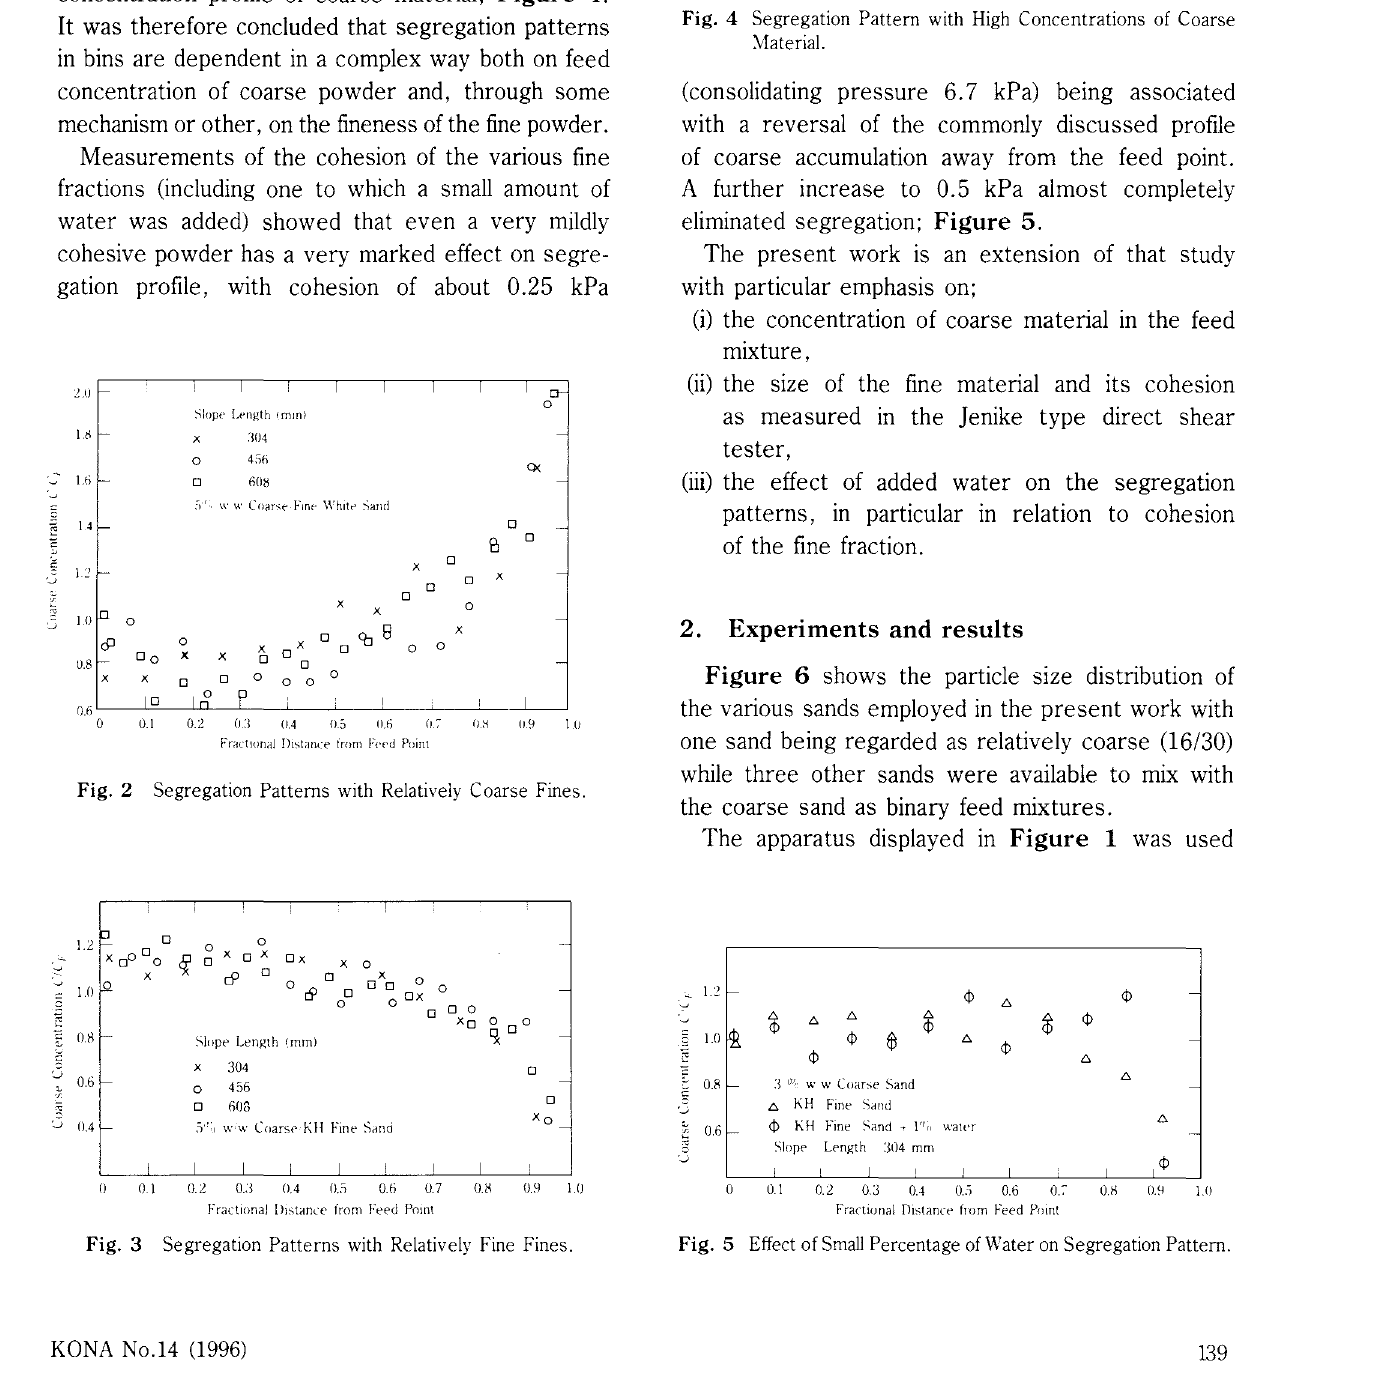
Fig. 4 Segregation Pattern with High Concentrations of Coarse :V1aterial.